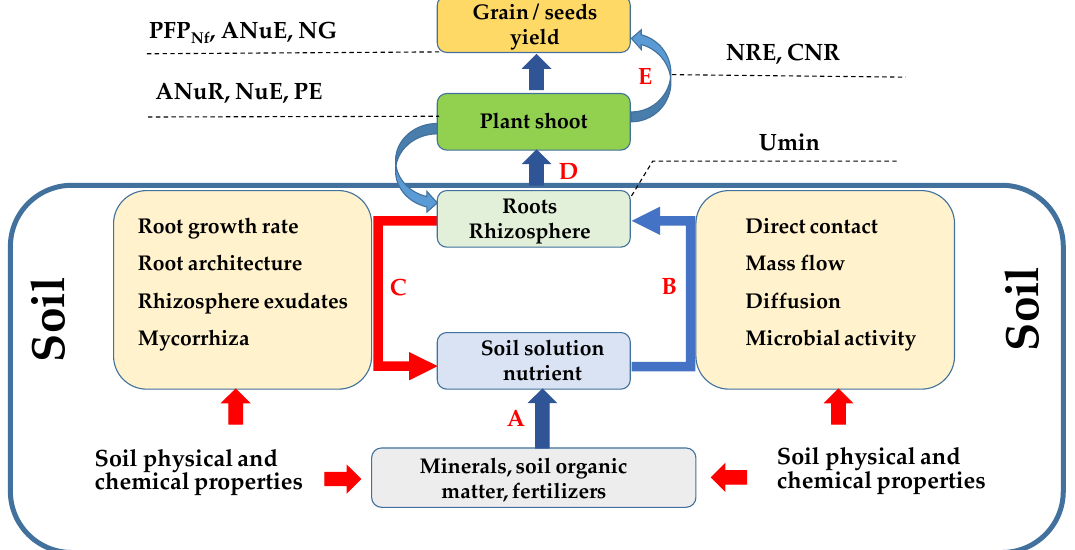
Figure 3. Fertilizer Use Effectiveness (FUE) indices in response to soil physical and chemical prop- erties and processes responsible for nutrient uptake: ( A ) release of nutrients from solid phase; ( B ) processes of nutrient transport from the soil to the root surface; ( C ) the plant’s physiological response to conditions of nutrient supply; ( D ) processes of nutrient transportation to the plant shoot; ( E ) nutrient remobilization and transfer into grain/seeds. Blue arrows—transport processes; red arrows—influencing and feedback responses. FUE indices explanations: PFP Nf —partial factor productivity of nitrogen; ANuE—apparent nutrient efficiency; NG—nitrogen gap; NRE—nitrogen remobilization efficiency; CNR—contribution of remobilized N to grain; ANuR—apparent nutrient recovery; NuE—nutrient uptake efficiency; PE—physiological N efficiency; U min —minimum uptake of a nutrient for the maximum rate of plant growth.